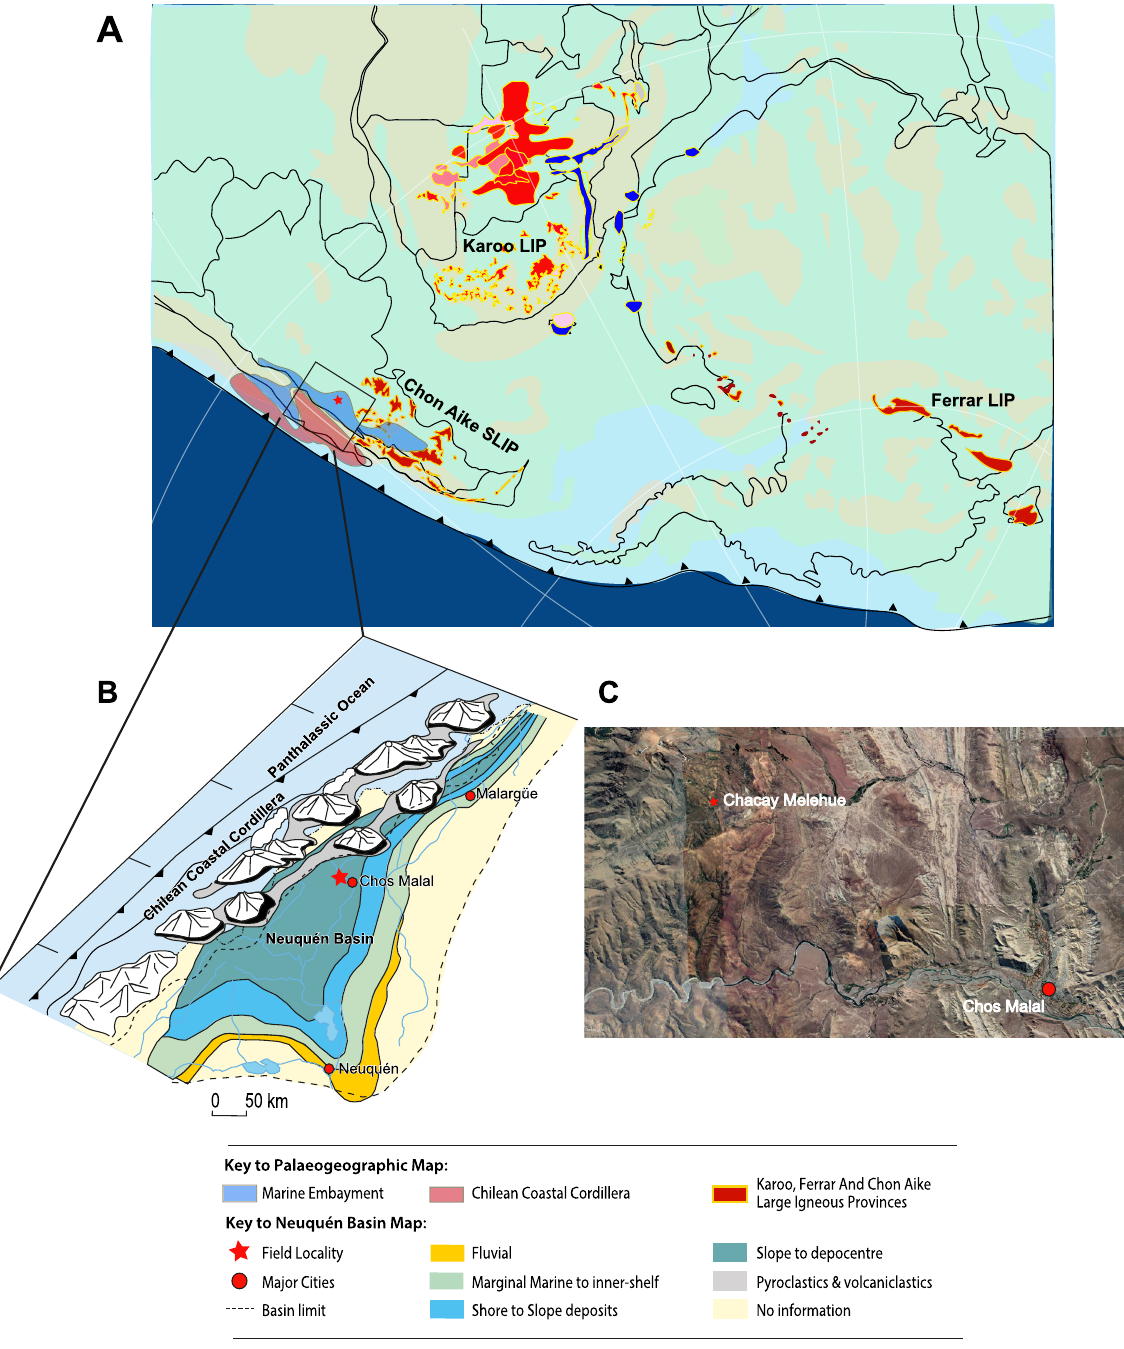
Figure 1. Palaeogeographic map for ∼ 183 Ma (after Blakey 22 ) showing ( A ) the location of Karoo Ferrar Large mafic Igneous Province, the Chon Aike Silicic Igneous Province 23–27 , and the Neuquén Basin reconstruction (after Vicente 28 ), and ( B ) the interior seaway, and depositional tracts within the basin (adapted and modified after 29–32 ). Location of Chacay Melehue is indicated by red star. ( C ) Satellite image showing location of Chacay Melehue (red star, 37° 15 ′ 18.26 ʺ S, 70° 30 ′ 16.34 ʺ W,) relative to Chos Malal. (Satellite image courtesy of Google Earth Pro. CM-ASH-3, at 19.24 m, gives a mean age of 182.836 ± 0.0951 Ma and a Bayesian eruption age estimate of 183.66 ± 0.21 Ma. CM-ASH-3 is located above the FO of Lotharingius barozii Noël (at 17.34 m; ash 2296R occurs at the same level). Lotharingius barozii Noël is characteristic of the latest Pliensbachian to earliest Toarcian disciforme–tenuicostatum Andean ammonite zones 50,55,56 as well as occurring above the FO of Dactylioceras (Eodactylites) cf. simplex (Fucini, FO 11.08 m) indicative of the early Toarcian tenuicostatum Zone 57 . The base of the Andean hoelderi Zone is identified in the section at 21.66 m and is marked by the FO of Harpoceras